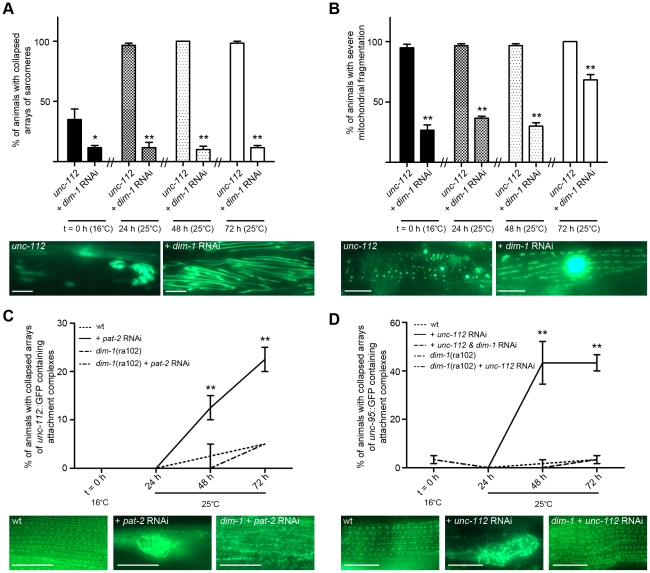
Loss of dim-1 suppresses attachment complex collapse and resulting pathologies.Where dim-1 RNAi was employed, indicated animals (wt or unc-112ts) were grown on RNAi targeting dim-1 for two generations and remained on dim-1 RNAi plates through the experiment. Age synchronised L1 stage indicated animals (wt, unc-112ts, or dim-1(ra102)) were gown to young adulthood at 16°C (t = 0 h) before being temperature shifted to 25°C and cultured for a further 72 h. 20 animals were picked and scored for identical pathology in at least two muscles at t = 0 h, 24 h, 48 h, and 72 h. A) Displayed are the percentage of animals containing a full length translational fusion of gfp to myo-3 (myosin heavy chain A) where tearing/collapse of arrayed sarcomeres was noted (five independent experiments, n = 100). Below the graph is an example of an untreated animal displaying tearing and collapse as well as an RNAi treated animal displaying a disorganisation of arrayed of sarcomeres (for comparison see normal, disorganisation, tearing, and collapse in Figure 3 and Figure S1). *, **Significant difference from untreated (P<0.01, P<0.001) B) Displayed are the percentage of animals containing mitochondrial and nuclear localized GFP where major fragmentation of the mitochondrial network was noted (five independent experiments, n = 100). Below the graph is an example of an untreated animal displaying major fragmentation of the mitochondrial network and no visible nucleus as well as an RNAi treated animal displaying moderate fragmentation of the mitochondrial network and a GFP expressing nucleus (for comparison see networked and moderate and severe fragmentation in Figure 4 and Figure S2). **Significant difference from untreated (P<0.001). C) Displayed are the percentage of animals containing unc-112+::GFP where tearing/collapse of arrayed attachment complexes was noted (three independent experiments, n = 60). Below the graph is an example of an untreated animal displaying normal arraying of attachment complexes as well as an RNAi treated animal displaying collapse of arrayed complexes into a ball and also a dim-1(ra102) RNAi treated animals displaying disorganisation of arrayed attachment complexes (for comparison see normal, disorganisation, and collapse in Figure S3). **Significant difference from all other conditions (P<0.001). D) Displayed are the percentage of animals containing unc-95::GFP where tearing/collapse of arrayed attachment complexes was noted (five independent experiments, n = 100). Below the graph is an example of an untreated animal displaying normal arraying of attachment complexes as well as an RNAi treated animal displaying collapse of arrayed complexes into a ball and also a dim-1 RNAi treated animals displaying disorganisation of arrayed attachment complexes (for comparison see normal, disorganisation, and collapse in Figure S3). **Significant difference between pat-2 RNAi treated wt versus all other conditions (P<0.001). All significance values are from two way repeated measures ANOVA. Scale bars represent 15 µm.